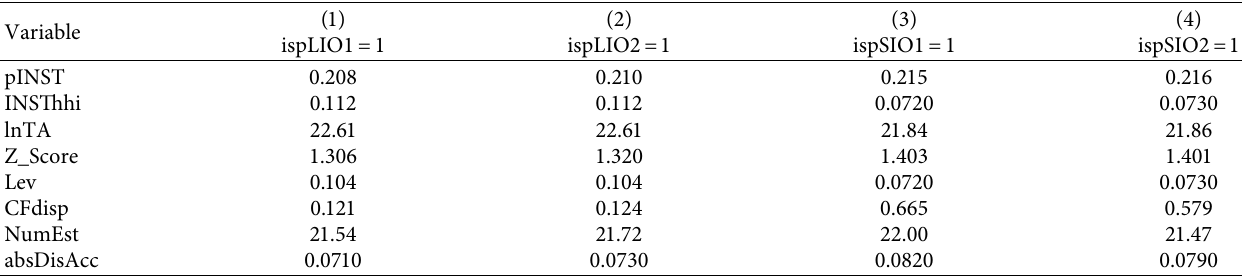
Table 2: Group descriptive